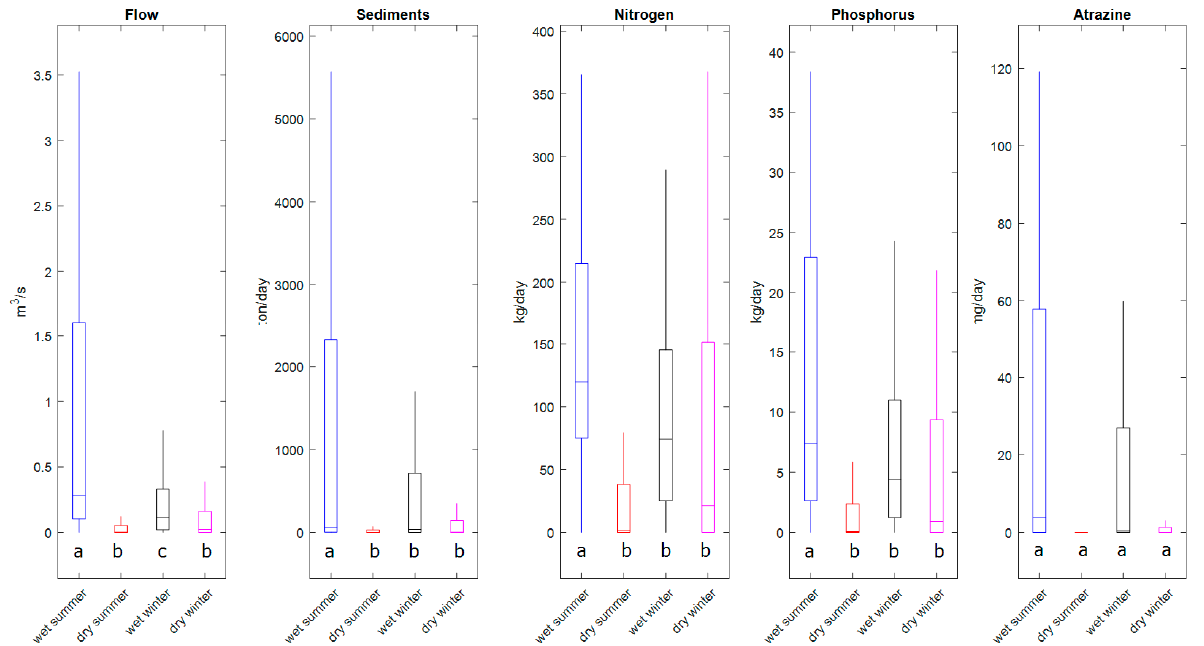
Figure 8. Simulated seasonal streamflow and pollutant loads under wet and dry conditions from 1910 to 2010, and multicomparison test results. Different letters show statistically significant differences between seasonal averages.